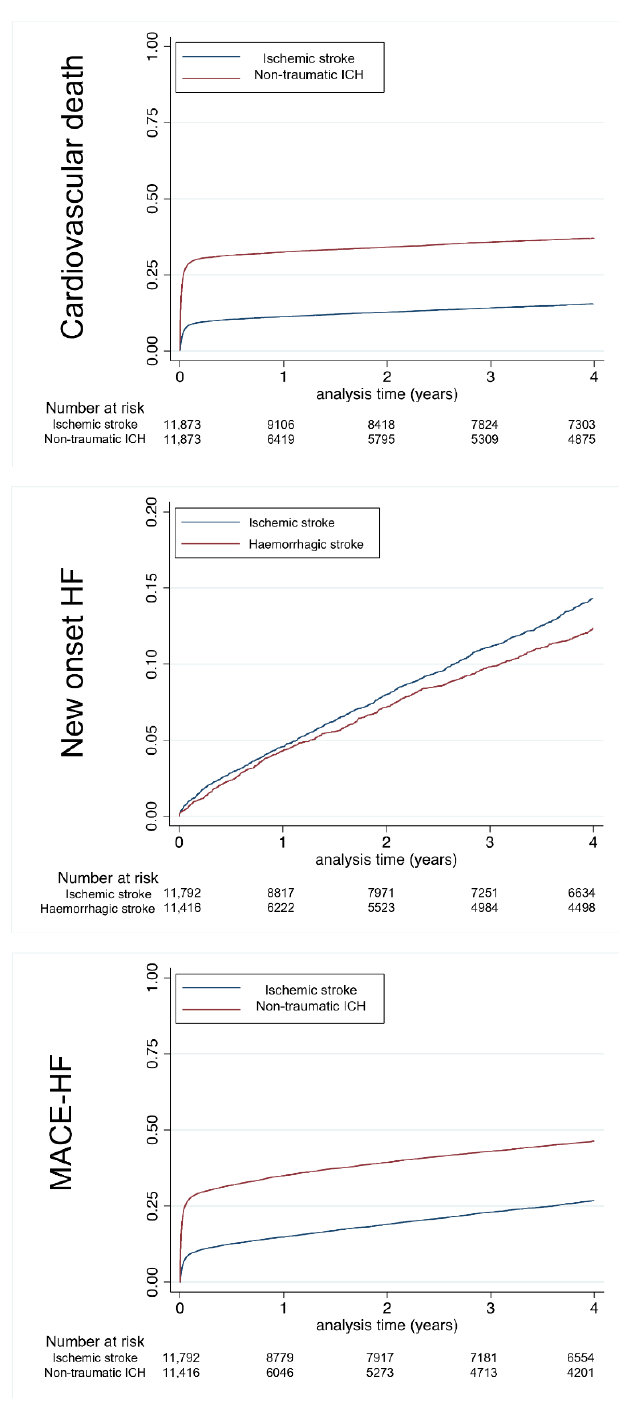
Figure 1. Cumulative incidences for all-cause death (top left panel), cardiovascular death (top right panel), myocardial infarction (middle left panel), new onset heart failure (middle right panel), new type of cerebrovascular event (ICrH for patients with history of ischemic stroke and ischemic stroke for patients with history of ICrH, left lower panel) and MACE-HF (right lower panel) during follow- up in the matched populations without comorbid AF. MACE-HF = Major cardiovascular events (in- hospital cardiovascular death, myocardial infarction, ischemic stroke or new-onset heart failure). ICH: non-traumatic intracranial hemorrhage.